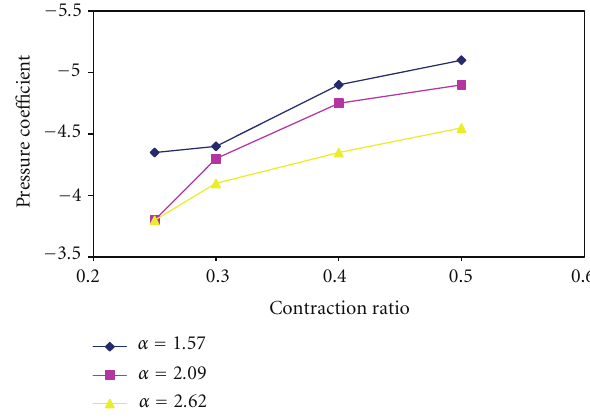
Figure 6: E ff ects of throat contraction ratio on pressure coe ffi cient of Venturi